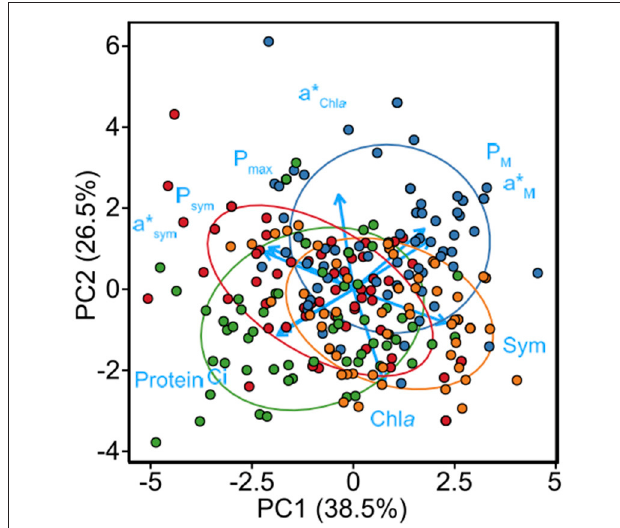
FIGURE 4 | Principal component analysis (PCA) plot showing the grouping of the unstressed specimens of Orbicella annularis (blue), Orbicella faveolata (orange), Montastraea cavernosa ( green), and Pseudodiploria strigosa (red), based on the structural (chlorophyll a , symbiont, Ci, protein content),